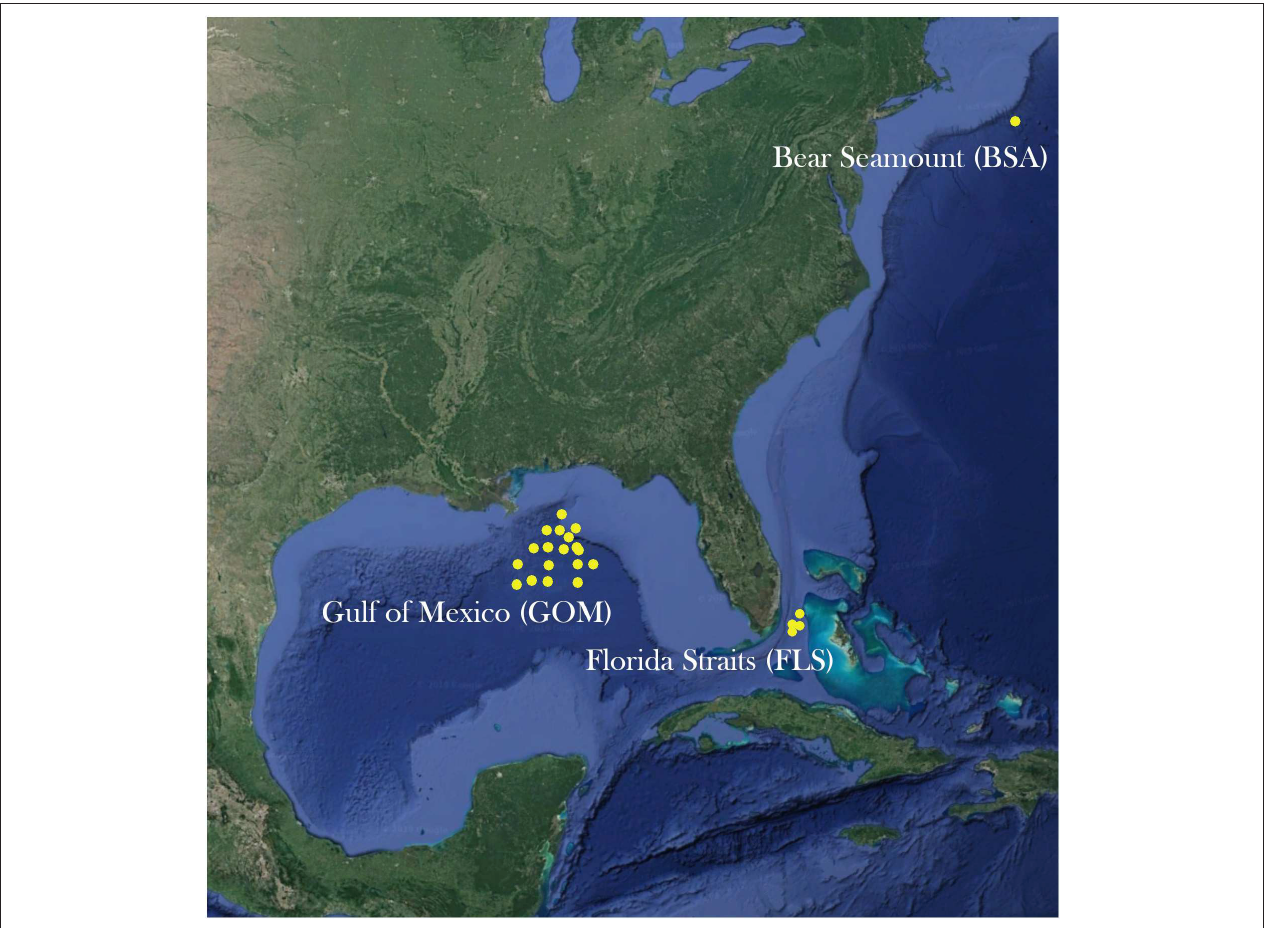
FIGURE 2 | A map of sites sampled from the Gulf of Mexico, the Florida Straits, and Bear Seamount in the Atlantic Ocean.